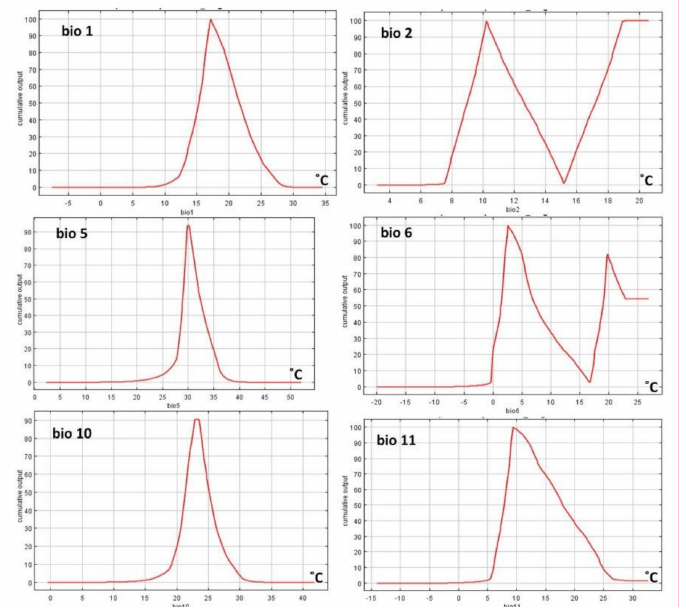
Figure 7. Response curves of temperature variables: annual mean temperature (bio1), and mean diurnal range (bio2), max temperature of warmest month (bio5), minimum temperature of coldest month (bio6), mean temperature of warmest quarter (bio10), and mean temperature of coldest quarter